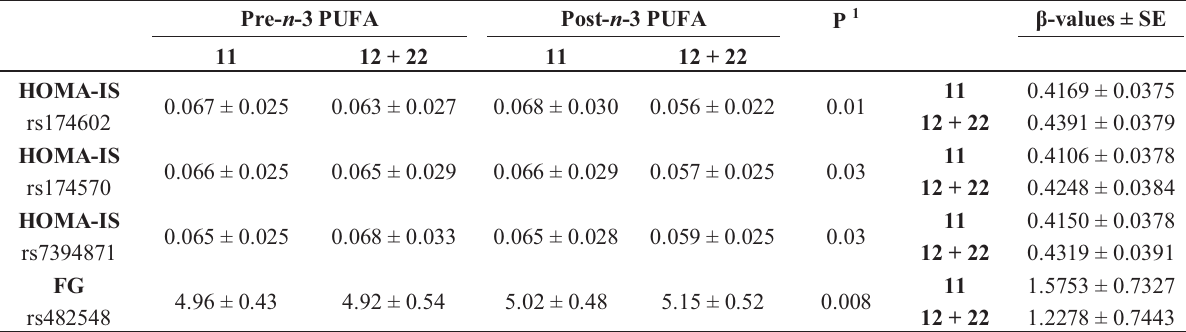
Table 3. Genotype by supplementation interaction effect on HOMA-IS and FG levels after a 6-week n -3 PUFA